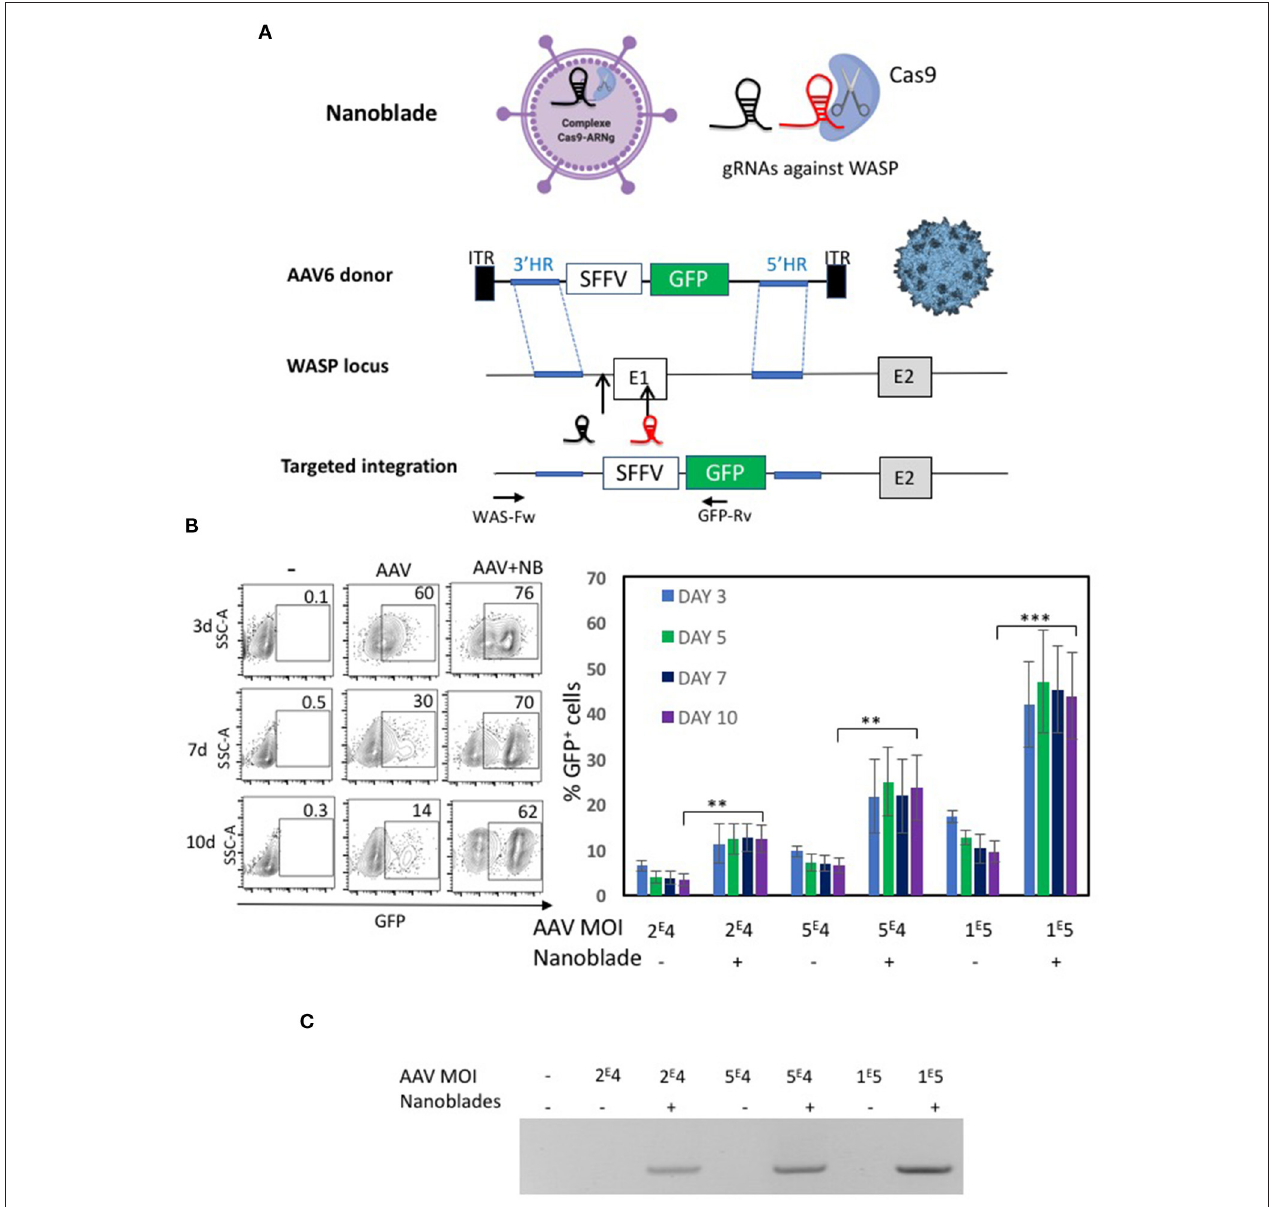
FIGURE 6 | Evaluation of nanoblades combined with rAAV6 encoding donor DNA for WAS gene locus knock-in. (A) Schematic representation of the nanoblades loaded with Cas9 and two sgRNA directed to the WAS locus (indicated before and inside the first exon) and the rAAV6 genome carrying the donor DNA for homologous recombination (HR); 3’ HR and 5’HR arms are indicated. An expression cassette with GFP under control of the SFFV promoter was inserted between the HR arms. Targeted integration is represented with primer positions indicated used to confirm specific integration (WAS-Fw and GFP-Rv ) . (B) K562 cells were treated with rAAV6 vector alone or rAAV6 combined with MLV based nanoblades. A representative flow cytometry plot for GFP + K562 cells is shown for day 3, 5, 7, and 10 post-treatment (left). A summary of the results is shown in the graph on the right (means ± SD; n = 4; student t -test, ** p < 0.01, *** p < 0.001). MOIs for rAAV are indicated. (C) K562 genomic DNA at day 12 post-treatment was isolated and integration was determined by PCR using WAS-Fw and GFP-Rv indicated in A . The gel is representative of n =